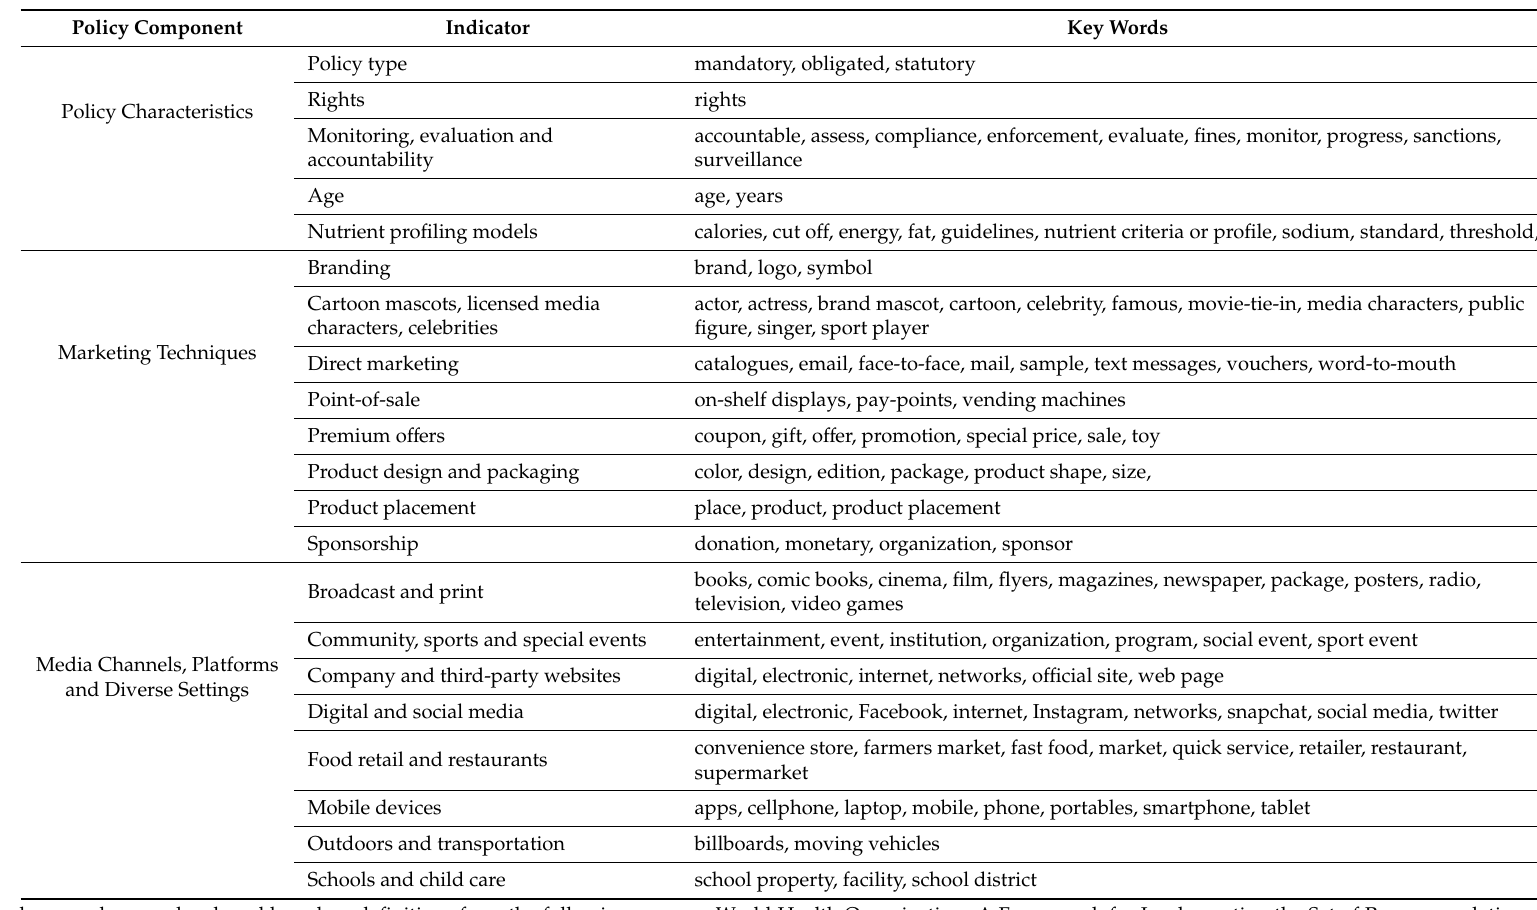
Table 2. Search terms used to identify policies from selected countries of the Americas Region for data inclusion, extraction, and coding for the RESPI for the marketing of high in fat, sugar, and salt (HFSS) food and beverage products to